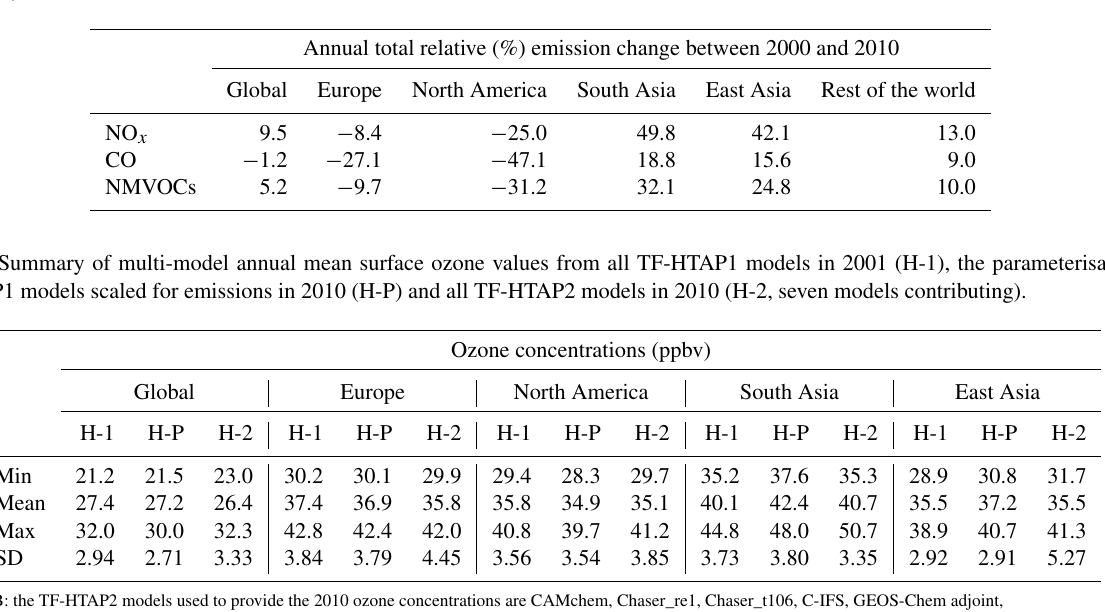
Table 1. Summary of annual mean NO x , CO and NMVOC emission changes (%) between 2000 and 2010 over TF-HTAP1 source regions (values are mean differences from the MACCity and Emissions Database for Global Atmospheric Research (EDGAR) v4.3.1 emission inventories).